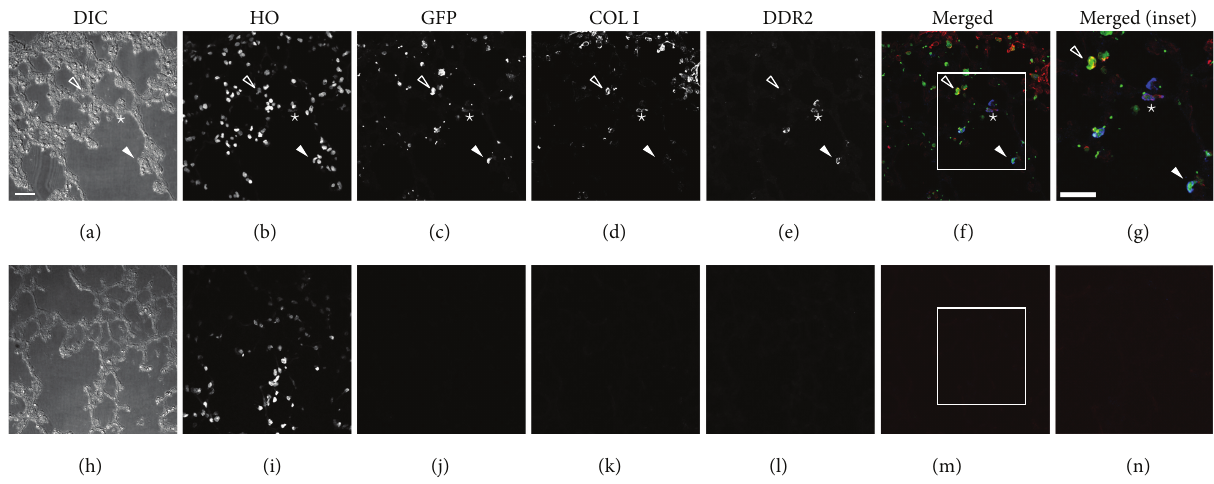
Figure 5: EGFP + lung fibroblasts are present in the lungs of nonadherent transplant engrafted mice. Differential interference contrast (DIC), Hoechstnuclearstain(HO),GFP,CollagenI,andDDR2antibodystainareshownfromarepresentativelungsectionfromanengraftedanimal in Panels (a)–(e), respectively. Panel (f) shows merged image of GFP (green), Collagen I (red), and DDR2 (blue) staining. A representative GFP + /Collagen I + /DDR2 + cell is indicated by *; a representative GFP + /Collagen I + cell is indicated by an open arrow head; a representative GFP + /DDR2 + cell is indicated by a solid arrow head. Panel (g) shows higher magnification of inset (boxed area) in Panel (f) with * indicating a GFP + /CD45 + /DDR2 + expressing cell. Panels (h)–(n) depict images of secondary only controls. Bar = 25 𝜇 M.